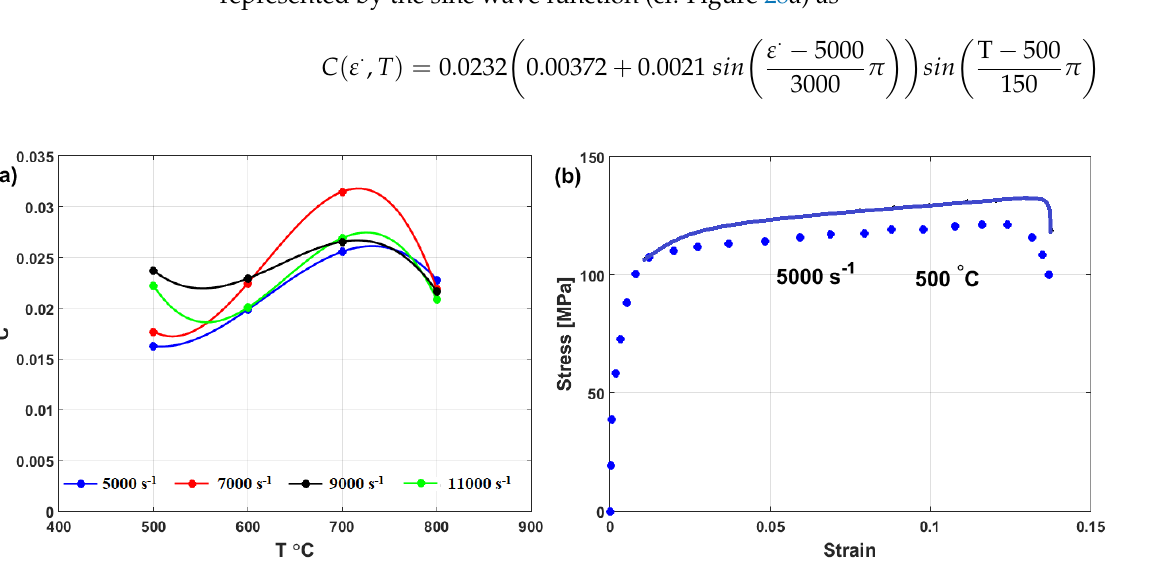
Figure 28. ( a ) Determination of C as a sine wave function and ( b ) comparison between experimental stresses (markers) and predicted stresses (solid line) obtained by the modified JC model that was presented Wang et al. [48].